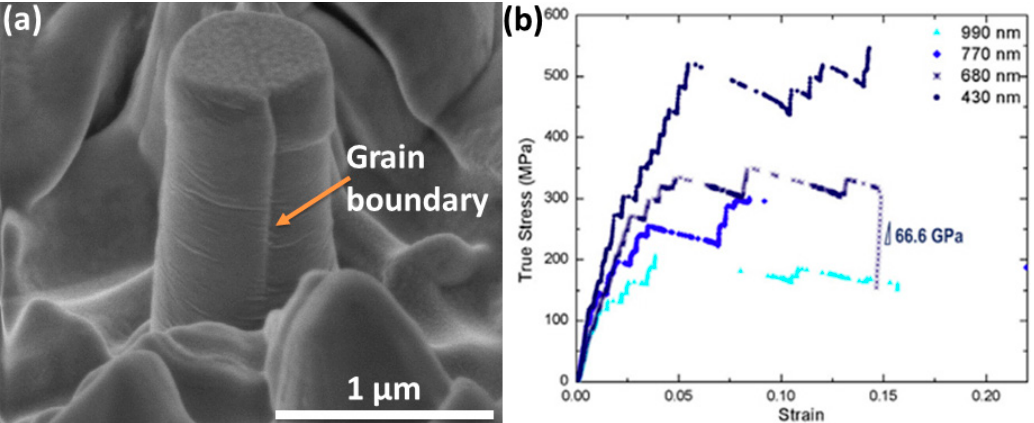
Figure 5. ( a ) SEM image of a bicrystalline submicrometer Al pillar containing a vertical grain boundary (GB) intersected with the top surface; ( b ) representative stress-strain curves for bicrystalline pillars with different diameters [35] ( Reprinted from Acta Materialia, Copyright 2011, with permission from Elsevier ).